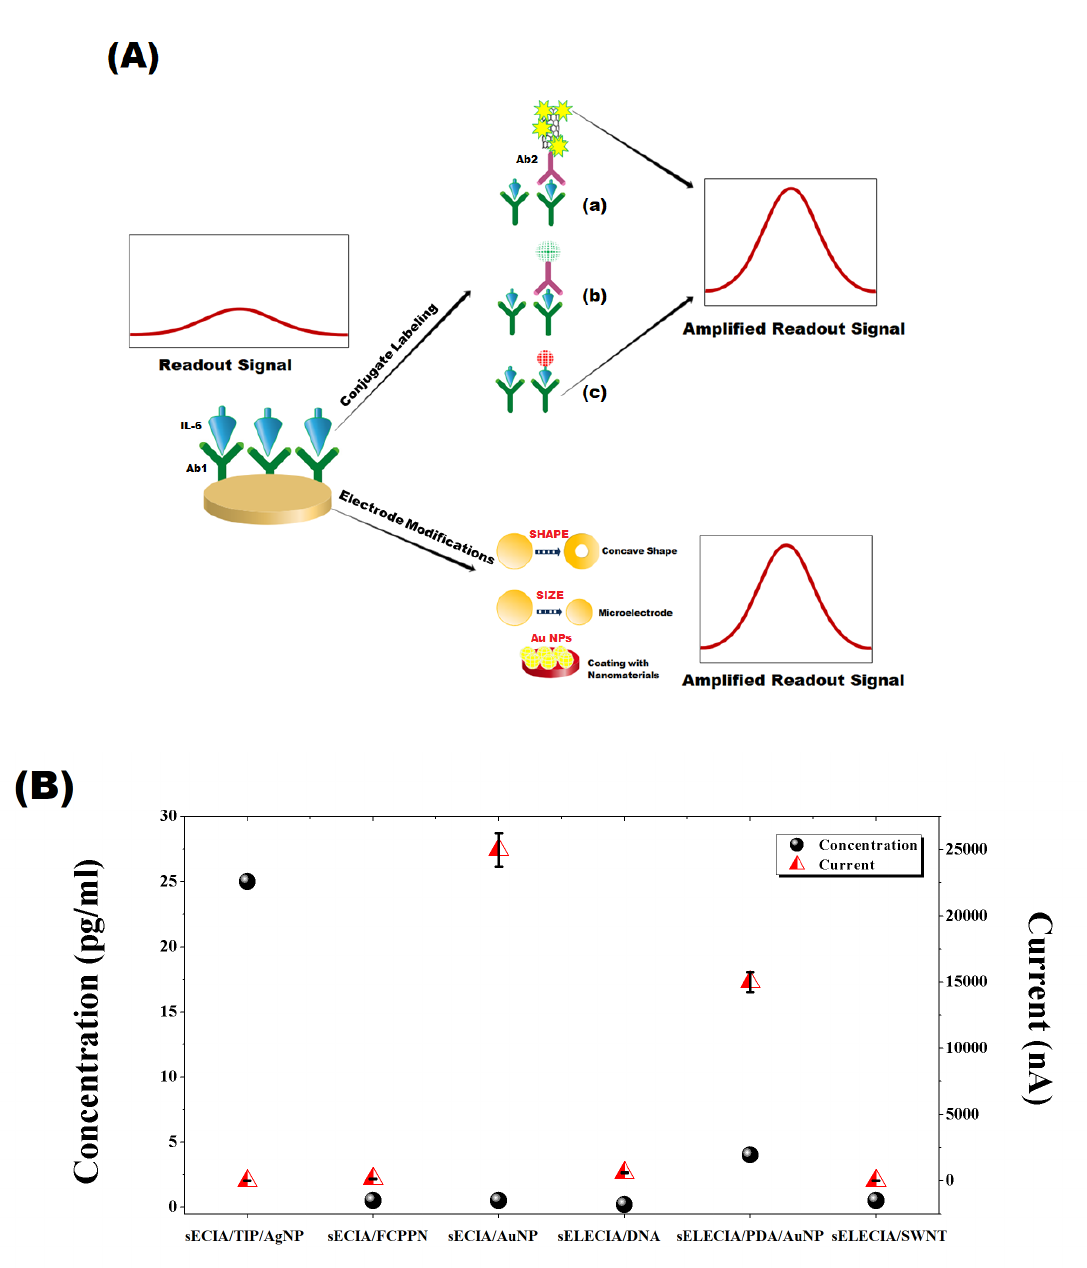
Figure 4. ( A ) Signal amplification strategies: ( a ) use of combination of nanomaterials and multi-enzyme labels on a secondary antibody to enhance the outgoing signal, ( b ) use of electro-active (AuNPs or electro-conductive polymeric) NPs, ( c ) a competitive approach in which analyte labeled with electro-active nanoparticles competes towards complex formation with Ab 1 immobilized on electrode surface. Electrode modification approach involves controlling geometry and coating with conductive nanoparticles to boost the change in detecting signal. ( B ) Signal to Least detectable concentration plot for different ECIA scheme sECIA/Titanium Phosphate (TiP)/AgNP [105]; sECIA FC/PPN [107]; sECIA/AuNP [106]; sELECIA/DNA [110]; sELECIA/PDA/AuNP [109]; sELECIA/SWNT (single-walled carbon nanotubes)